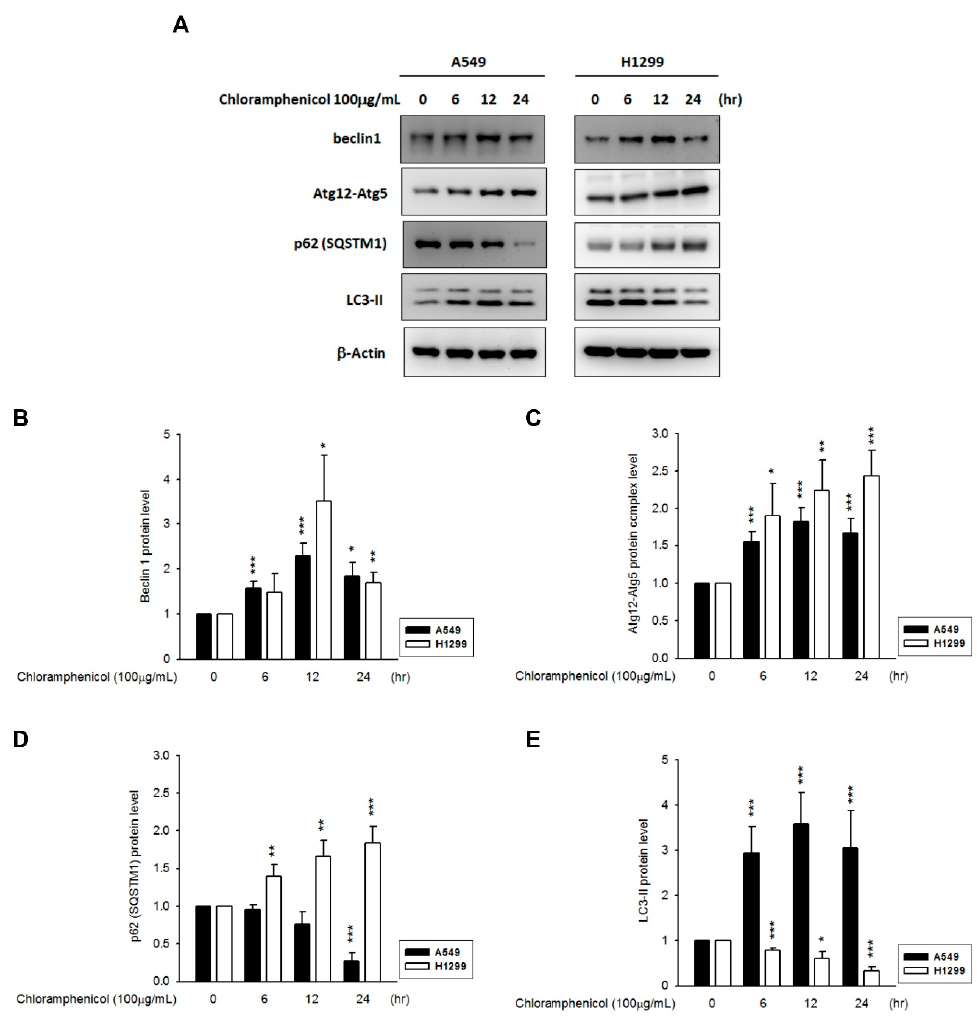
Figure 4. Chloramphenicol induced autophagy in NSCLC cells in a time-dependent manner. ( A ) Representative images showing the changes in levels of autophagy biomarkers (beclin 1, Atg12-Atg5 conjugates, p62/SQSTM1, and LC3-II) in A549 and H1299 cells in response to chloramphenicol treatment. Quantitative results of multiple experiments are shown for ( B ) beclin 1, ( C ) Atg12-Atg5 conjugates, ( D ) p62/STSQM1, and ( E ) LC3-II. (* p < 0.05, ** p < 0.01, and *** p < 0.001 indicates statistically significant difference from the control group). N = 5 (A549) and 3 (H1299).